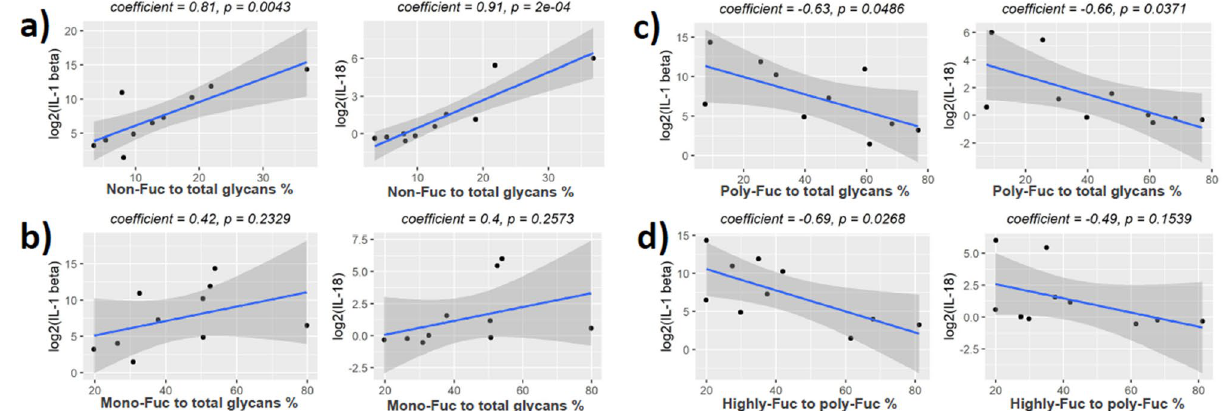
Figure 8. Correlation of fucosylation to IL-1 beta and IL-18 for glycans with 2 LacNAc units. Pearson’s product-moment correlation was used for statistical analysis. ( a ) Relative intensity of non-fucosylated glycans to the intensity of all glycans. ( b ) Relative intensity of mono-fucosylated glycans to the intensity of all glycans. ( c ) Relative intensity of poly-fucosylated glycans to the intensity of all glycans. ( d ) Relative intensity of highly fucosylated glycans to the intensity of poly-fucosylated glycans. Highly fucosylated glycans were defined as those with at least 3 Fuc per glycan. Poly-fucosylated glycans were defined as those with at least 2 Fuc per glycan.